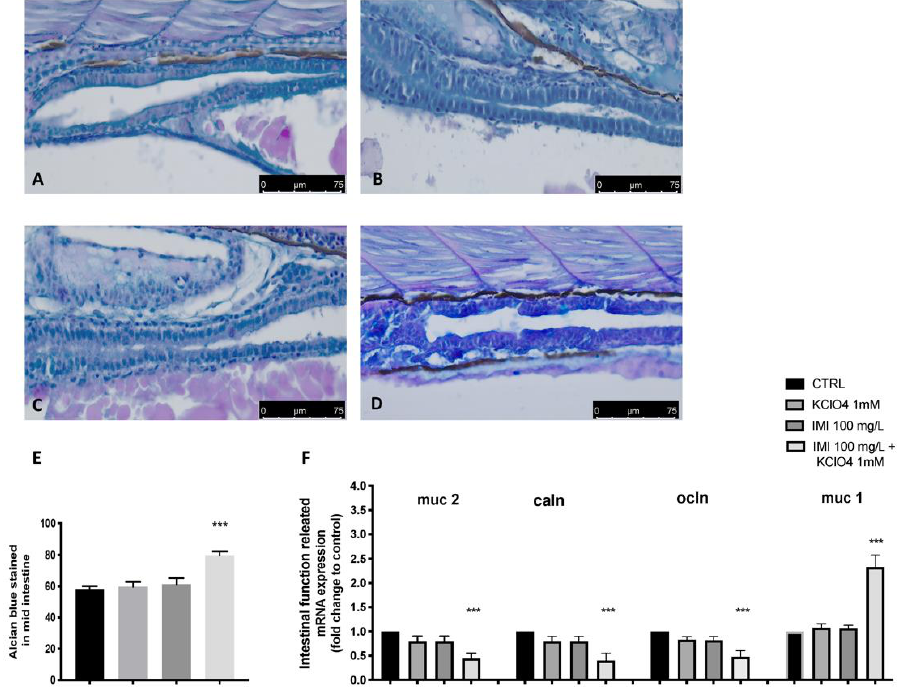
Figure 4. IMI and KClO 4 effect in single and co-exposure on mucopolysaccharides production. Whole-mount control, IMI and KClO 4 in single and co-exposure larvae stained with Alcian Blue. CTRL ( A ), KClO 4 ( B ), IMI ( C ); IMI+ KClO 4 ( D ). Increased mucus production (blue staining) ( E ). Effects of IMI and KClO 4 single and co-exposure on the mRNA levels of intestinal-function-related genes (muc2, caln, ocln and muc1) ( F ) in larval zebrafish. Values = means ± SEM of three independent experiment data; *** at p < 0.001 against CTRL.